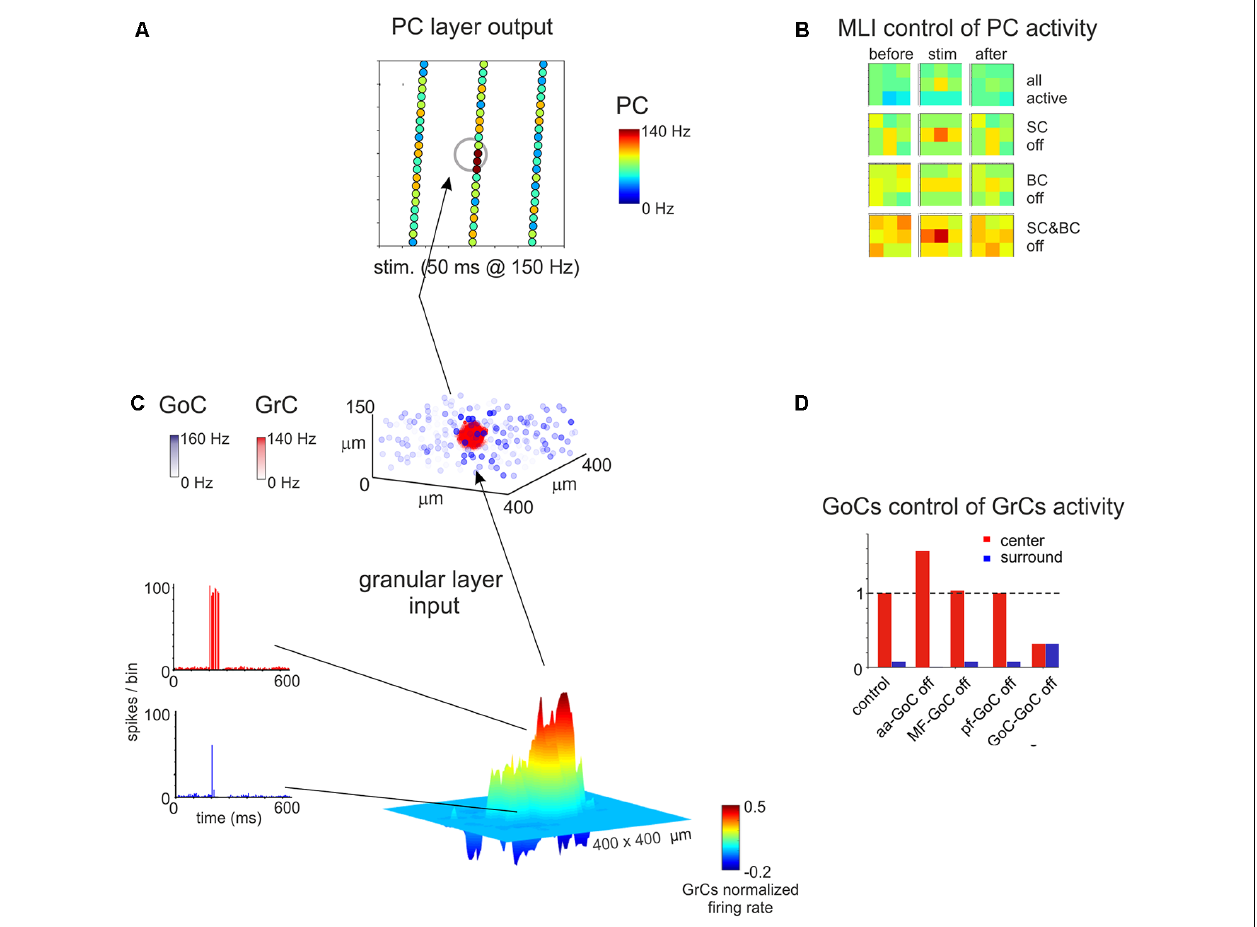
FIGURE 7 | Spatial organization of the granular and ML activity predicted by computational modeling. (A) The map shows the activity change of PCs in response to a MF burst. (B) The PC activity was averaged into 3 × 3 matrices in order to better appreciate when alternative patterns are generated. (C) In response to a MF burst, the GL responds with a core (red area) of activity surrounded by inhibition (blue area). The upper plot represents the activity of GoCs (blue) and GrCs (red) before and after the stimulus burst. (D) Peri-stimulus time histograms (PSTH) of GrCs in the center-surround. The activity in the core is characterized by robust spike bursts, while just sporadic spikes are generated in the surround. No activity changes are observed outside the center-surround structure. Adapted from Casali et al.